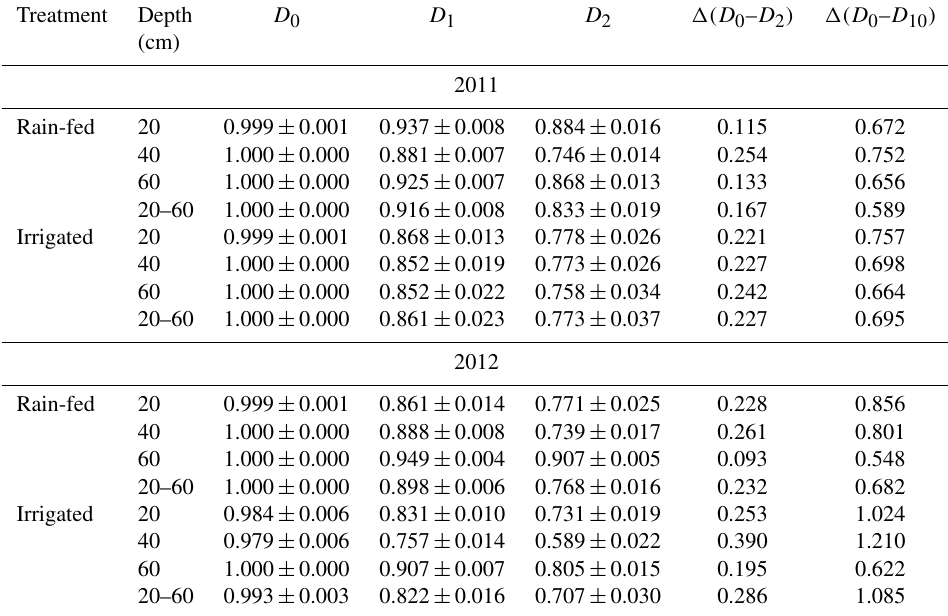
Table 1. Selected multifractal parameters: generalized dimensions, for the first three positive moments, D 0 , D 1 , and D 2 , with their respective errors of estimation, and two multifractality indices, (cid:49)(D 0 – D 2 ) and (cid:49)(D 0 – D 10 )